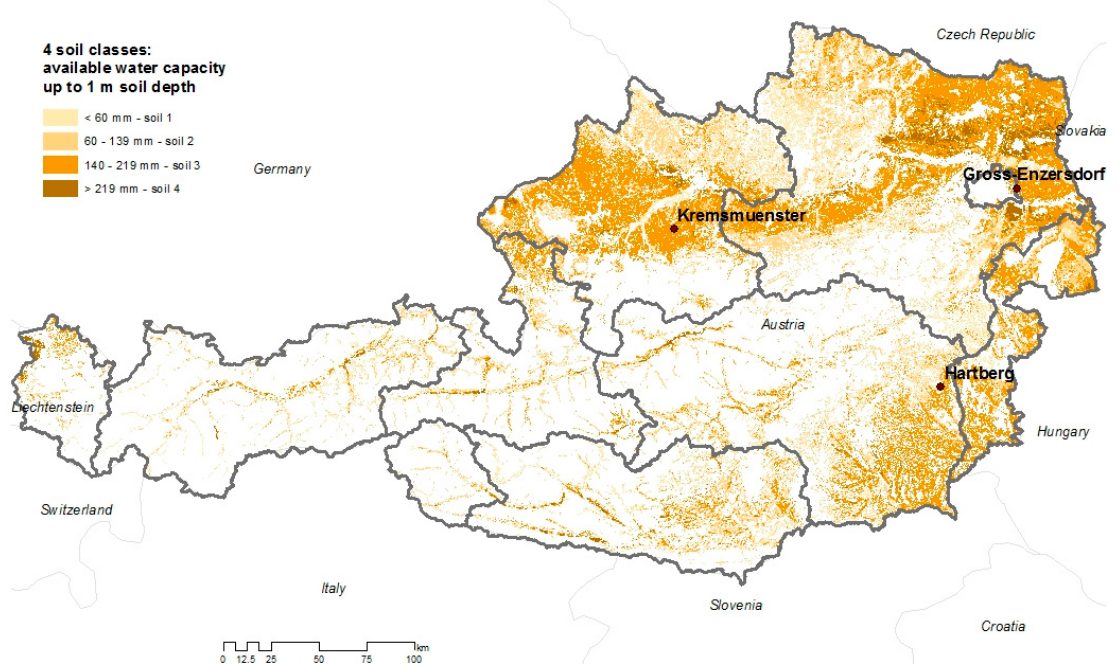
Figure 1. The four applied soil classes for agricultural land use for Austria and the three study sites.